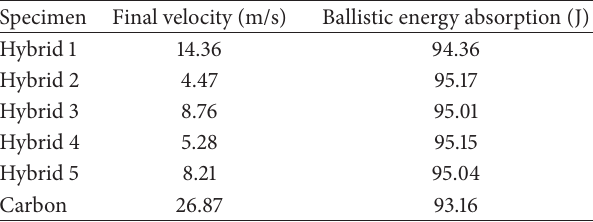
Figure 8: The perimeter of the impacted zones. 9292.59393.59494.59595.5 Figure 9: Comparing the amount of energy absorption in the specimens of 182m/s as the initial velocity. Table 2: Final velocity and energy absorption of the specimens. Specimen